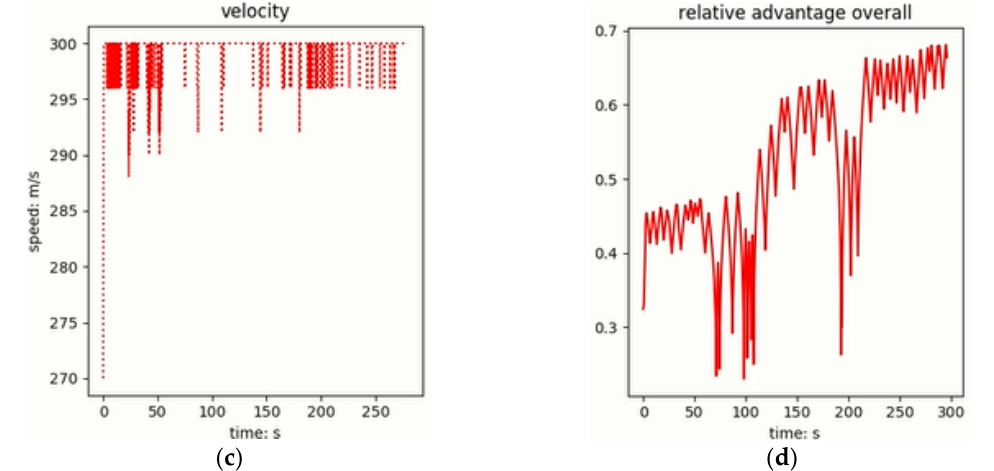
Figure 10. 2D advantage: native data change: ( a ) Threat ability; ( b ) Detection ability; ( c ) Speed; ( d ) Relative advantage.